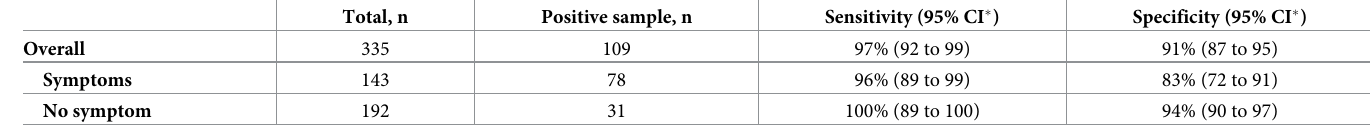
Table 2. Diagnostic accuracy of canine detection as compared to the reference standard (nasopharyngeal RT-PCR, positivity defined as at least one target gene being detected), according to the presence of symptoms in study